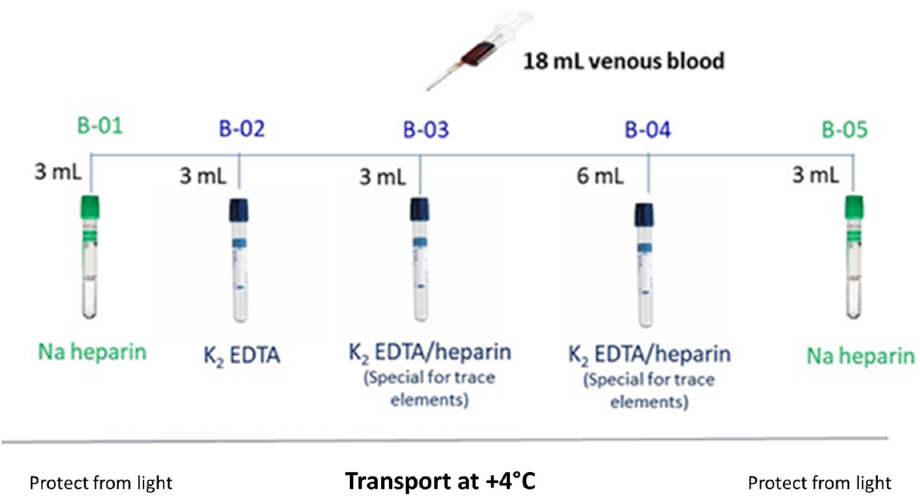
Figure 1. Venous blood sample collection.